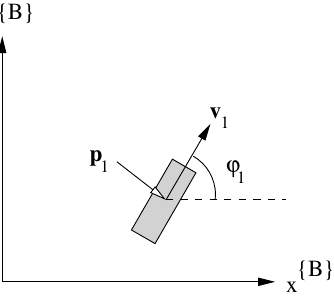
Figure 4. Wheel parameters: p 1 indicates the position, v 1 the velocity vector, v i = (cid:107) v i (cid:107) the velocity (scalar) and ϕ 1 is the steering